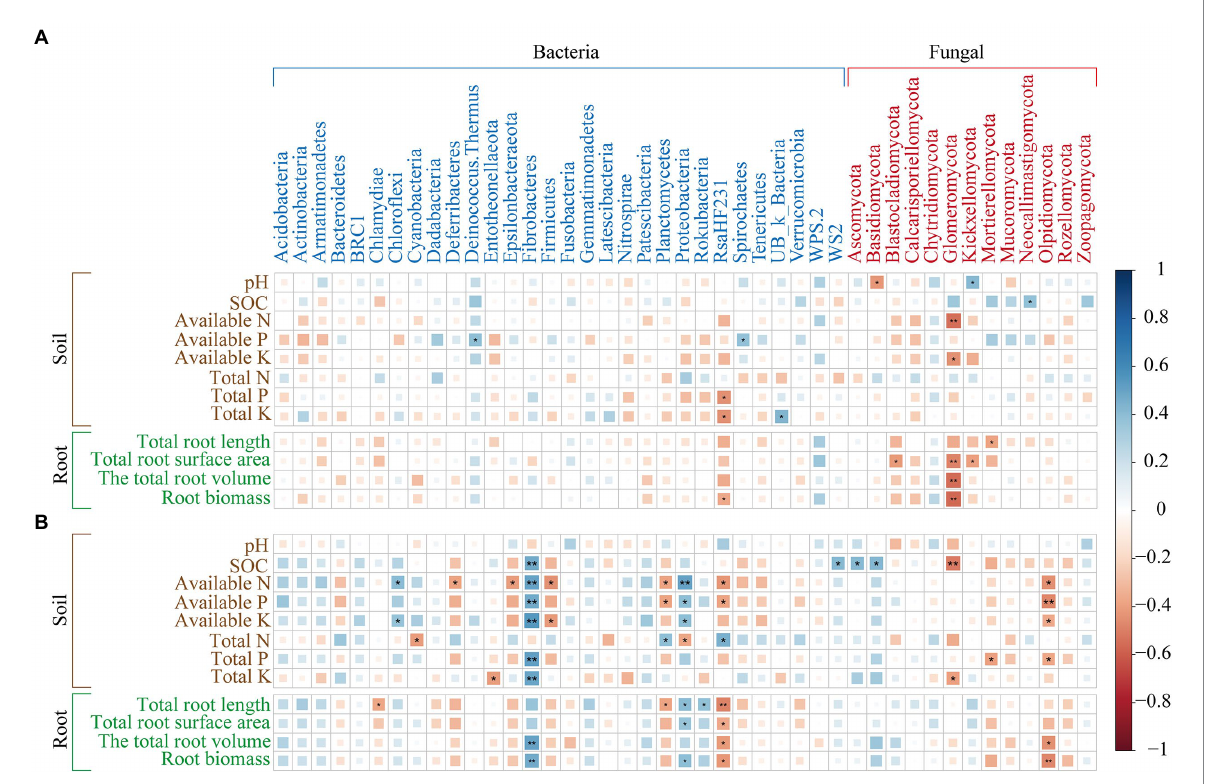
FIGURE 6 Relationships among soil microbial communities, soil physicochemical properties, and maize root architecture. (A) Communities in bulk soil. (B) Communities in rhizosphere soil. * p < 0.05; ** p <